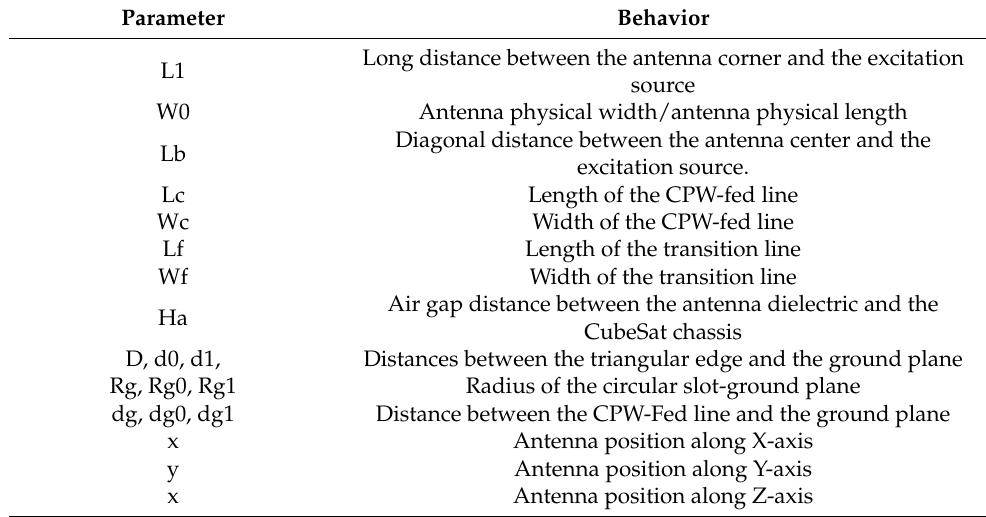
Table A1. Antenna parameters used in designing the proposed antennas.